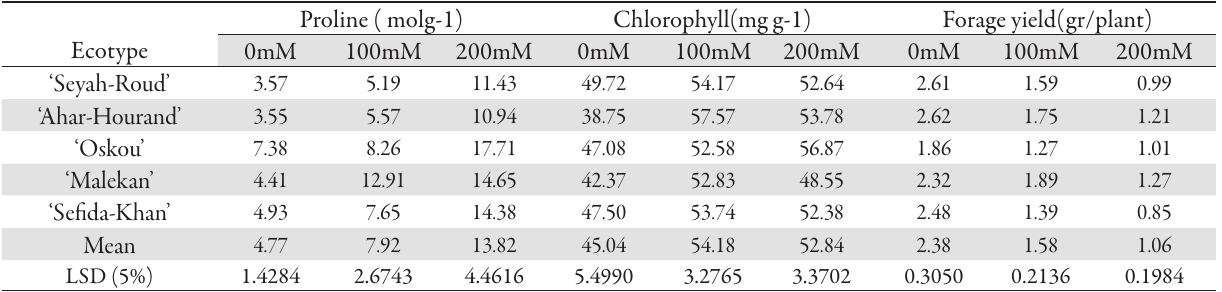
Tab. 3. Effect of salinity on accumulation of proline, total chlorophyll and forage yield of different alfalfa